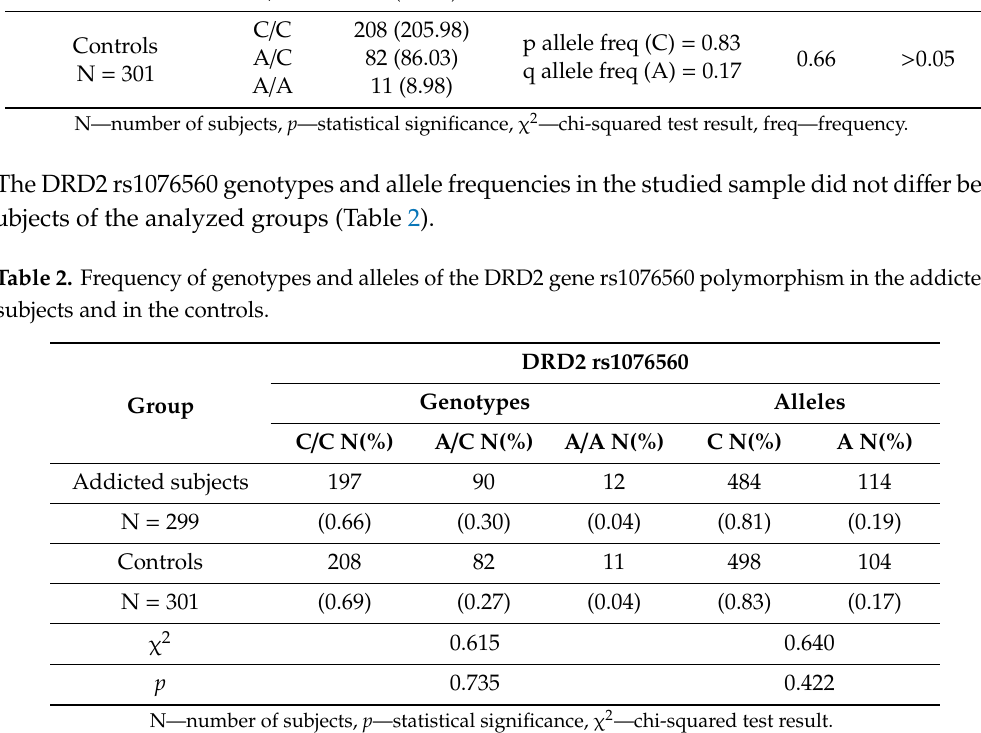
Table 1. Hardy-Weinberg equilibrium of DRD2 rs1076560 in the group of addicted subjects and controls. Group